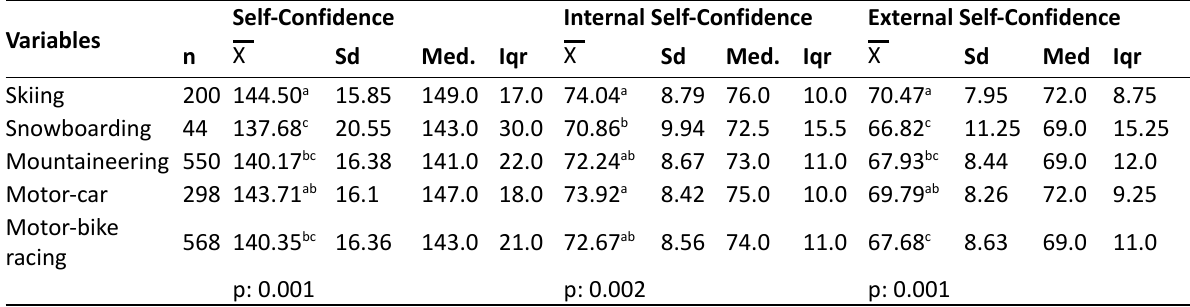
Table 1. Comparison of self-confidence and sub-scales in terms of branches Variables